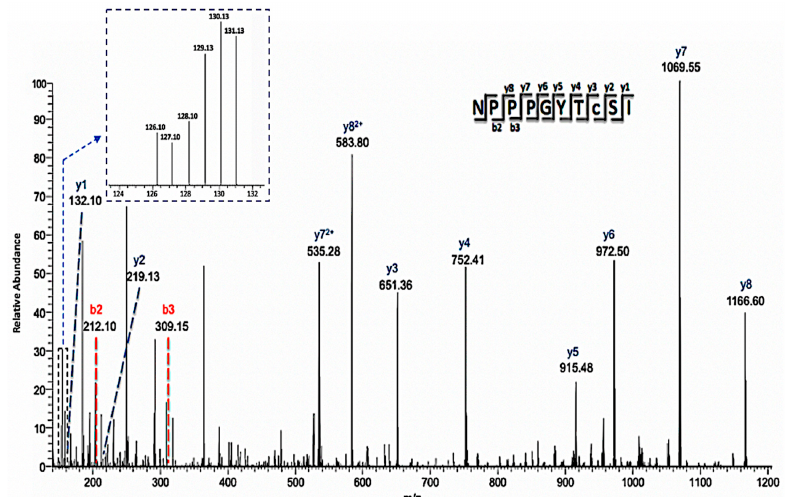
Figure 6. Annotated mass spectrum of a representative cysteine-containing peptide (C8-iodoTMT) showing differential redox status from control and treated samples. The MS/MS ions used to identify the peptide were labeled, and the intensity of the individual iodoTMT peaks for quantification was inserted in the upper left corner. This peptide is one of two that was used to identify lipid-transfer protein isoform II as a potential NO regulated protein.